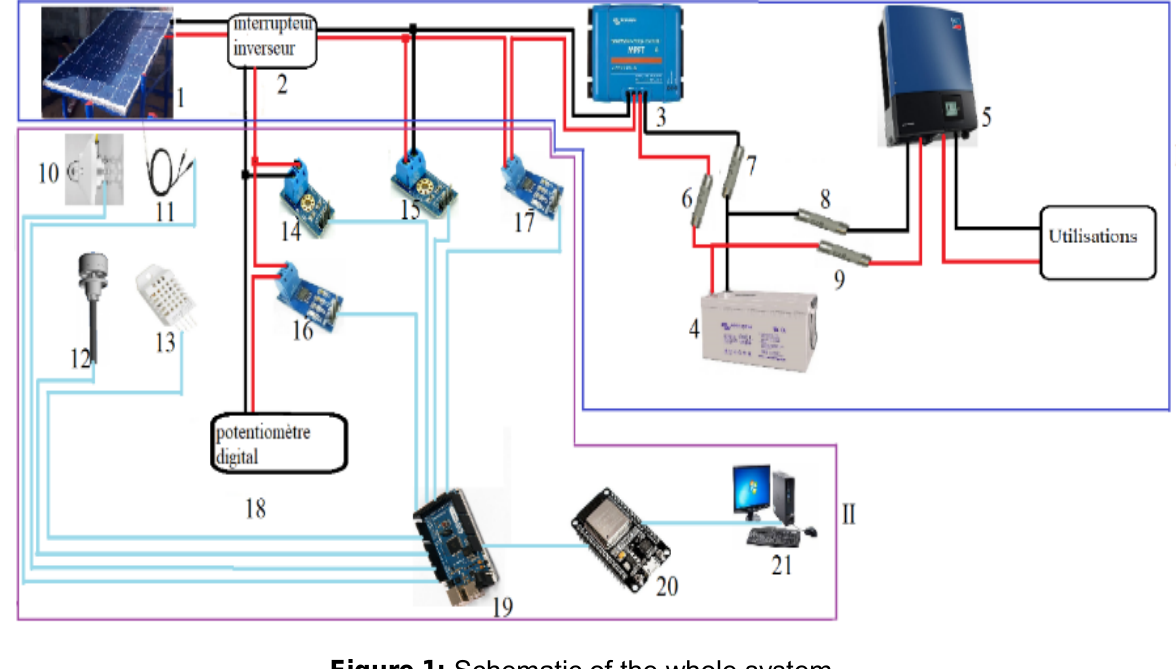
Figure 1: Schematic of the whole